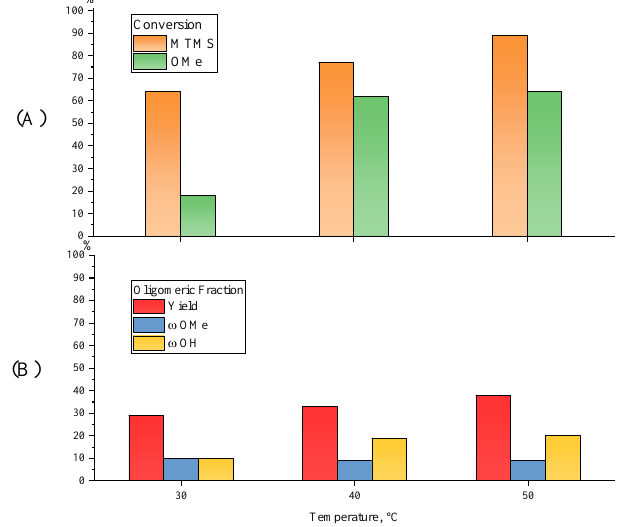
Figure 11. Diagrams of monomer and MeO-group conversions ( A ) and of the yield, MeO- and OH- group contents for the oligomeric fraction obtained by MTMS MWHP ( B ) at different temperatures and an MTMS/H 2 O molar ratio of 1/1.5, at 20 W for 5 min (Samples 7, 16–17, Table 1).